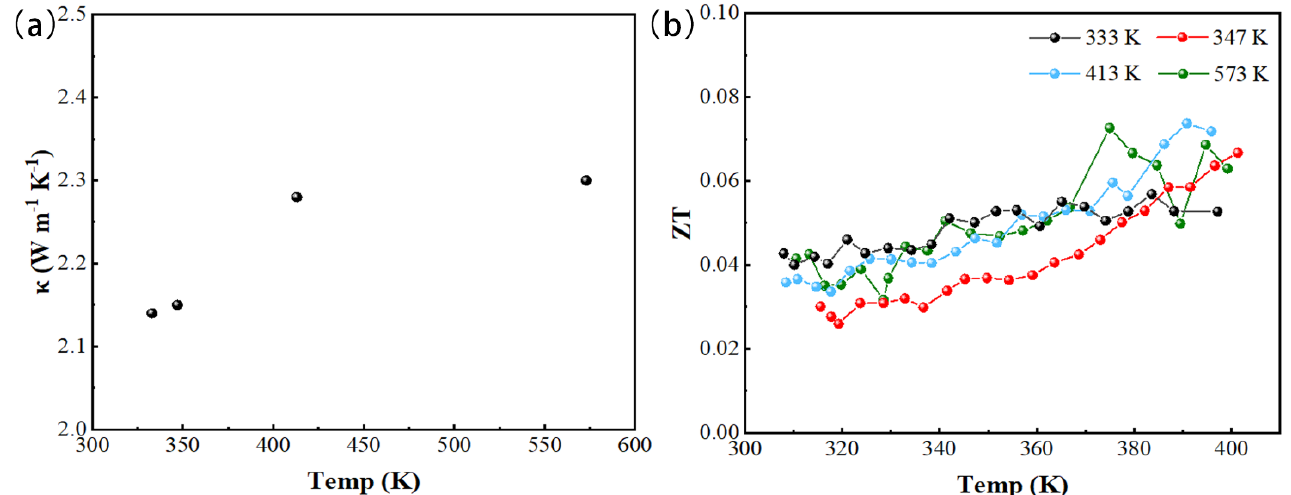
Figure 6. ( a ) Thermal conductivity values measured in multiple samples prepared at different temperatures, ( b ) The calculated ZT for the Cu 2 Se thin film. Table 3. Research progress of Cu2Se thin-film thermoelectric properties in recent years.